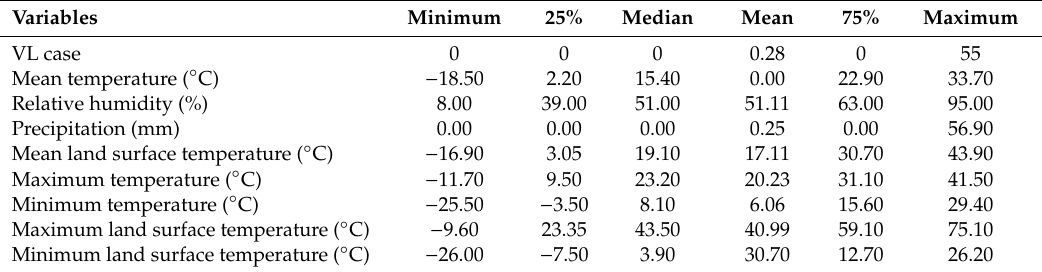
Table 1. Summary of visceral leishmaniasis (VL) cases and meteorological factors *.